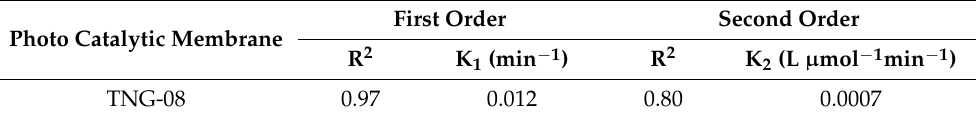
Table 3. Values of co-efficient of correlation and rate constant of MO degradation using TNG-08. Photo Catalytic